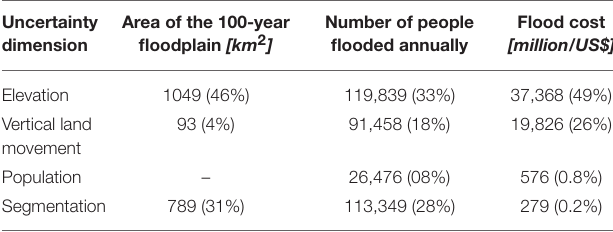
TABLE 4 | Sensitivity of coastal flood impacts to the four uncertainty parameters in 2100 (SSP5, high